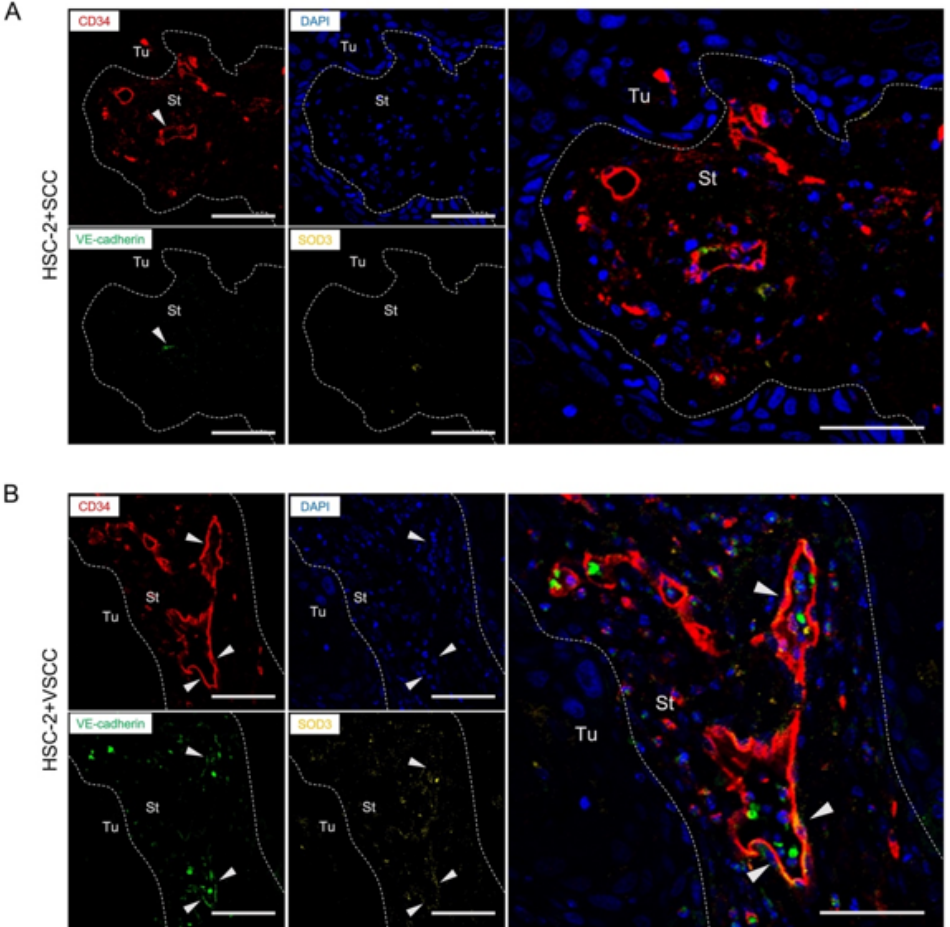
Figure 5. SOD3 expression in stromal cells correlates with vascular integrity ( A ) Representative images of multicolor IHC detection on CD34 (red), VE ‐ cadherin (green), and SOD3 (yellow) in HSC ‐ 2+SCC xenograft. ( B ) Representative images of multicolor IHC detection on CD34 (red), VE ‐ cadherin (green), and SOD3 (yellow) in HSC ‐ 2+VSCC xenograft. Arrowheads indicate the merged cells. Dotted lines represent the boundary of the tumor (Tu) and stroma (St) area. Scale bars: 50 μ m.